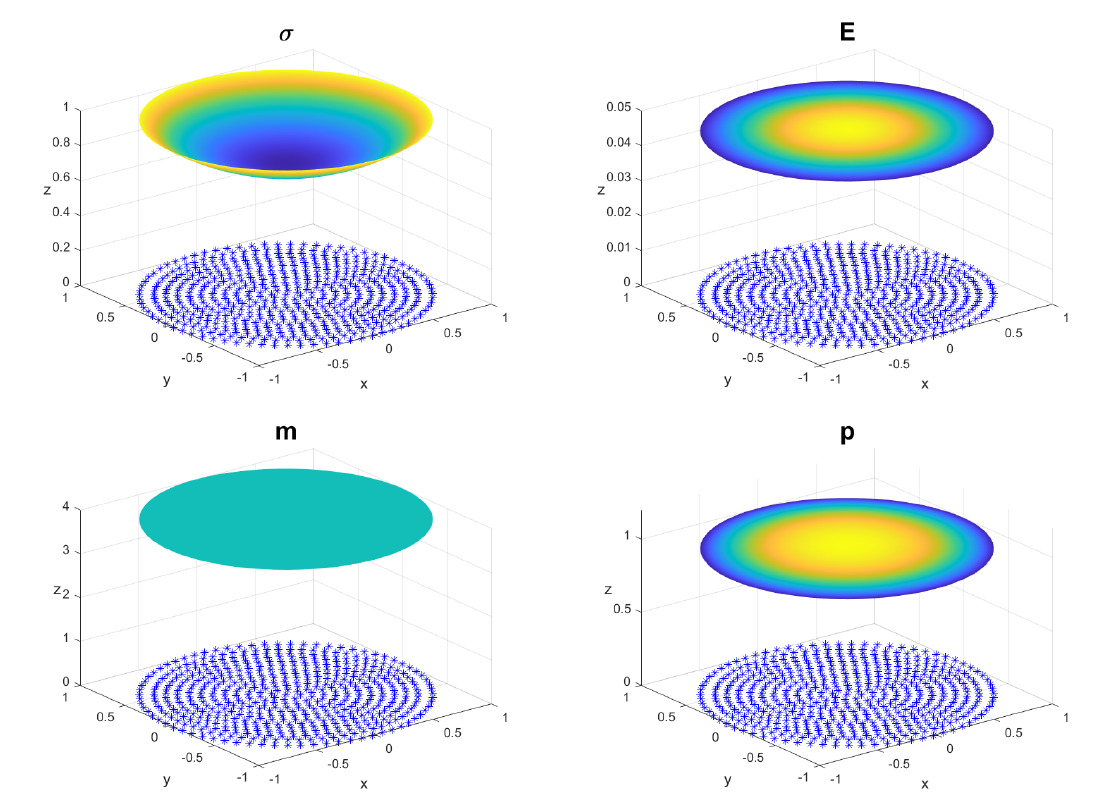
Figure 7. Graphs of the functions: σ , E , m and p for t = 10